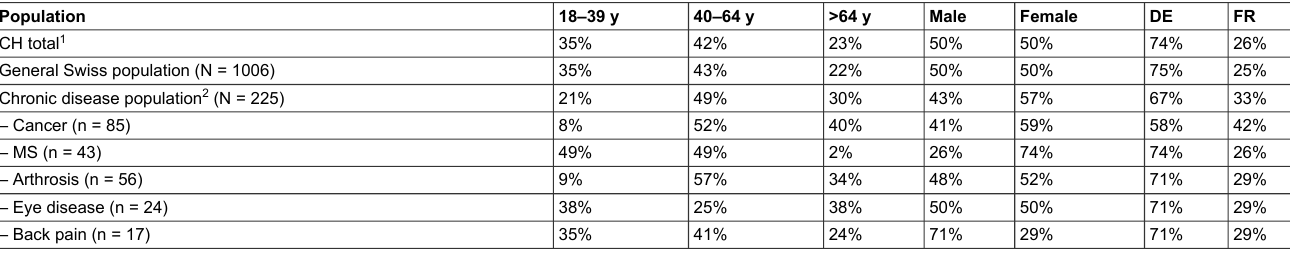
Table 1: Demographic characterisation of survey participants.